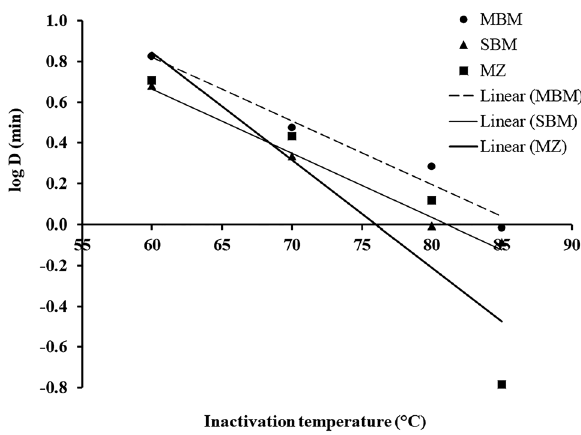
Figure 2. DRT curves were fitted to the log D T of ASFV in feed ingredients.